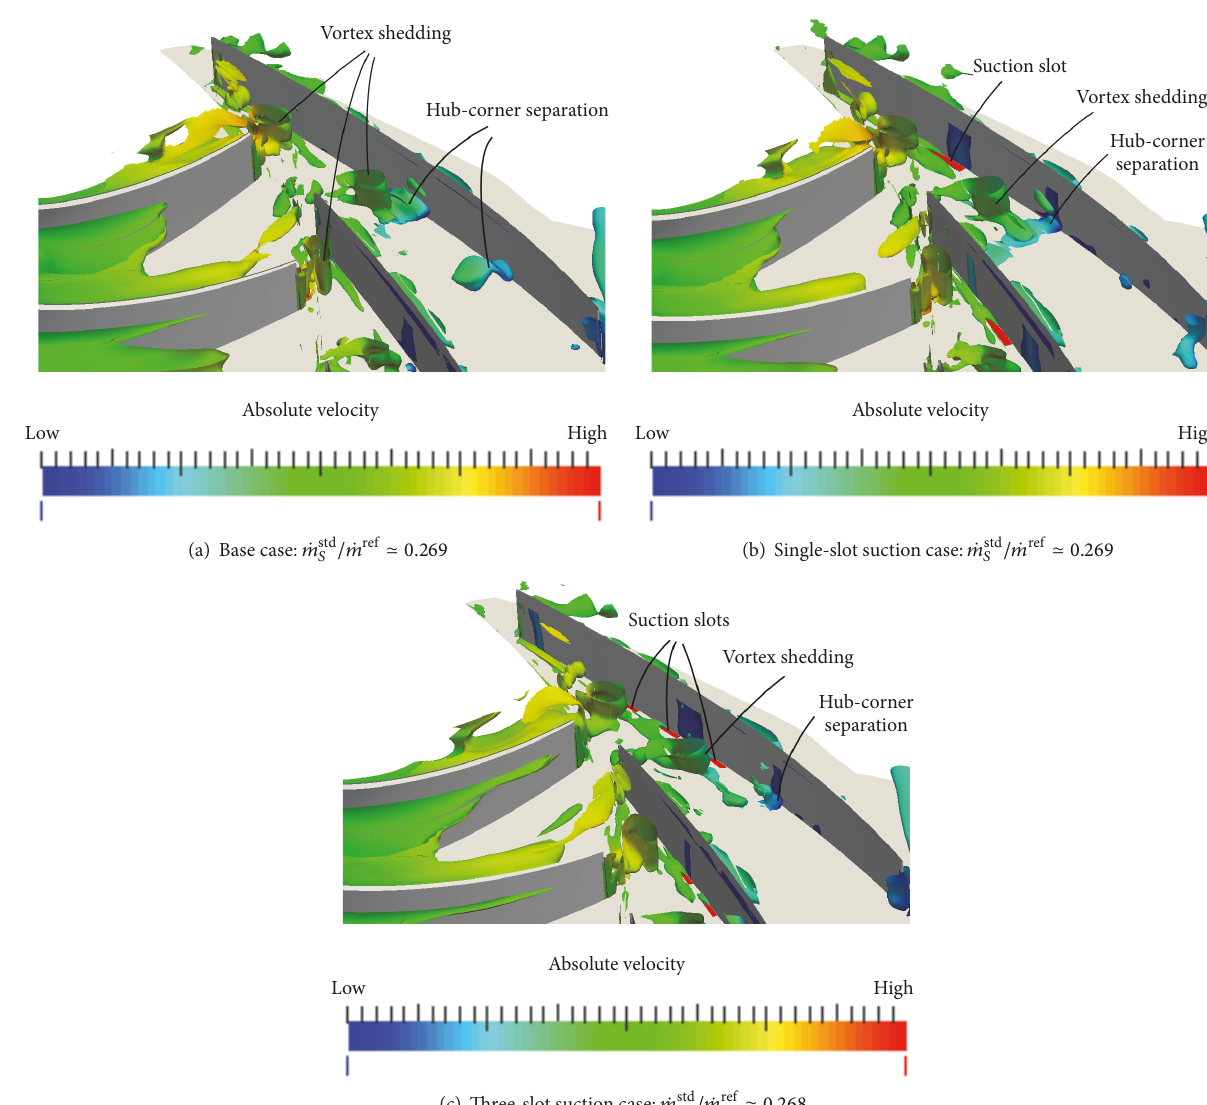
Figure 9: Isocontours of 𝑄 -criterion in the diffuser colored by velocity: 𝑄 = 30